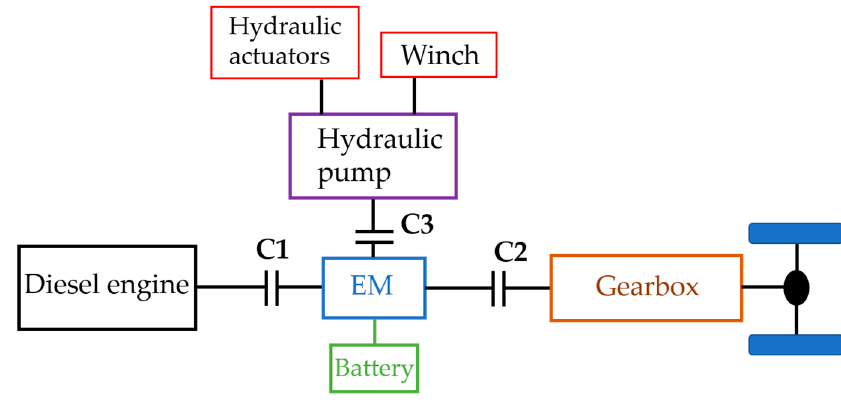
Figure 4. Proposed hybrid power-train configuration.